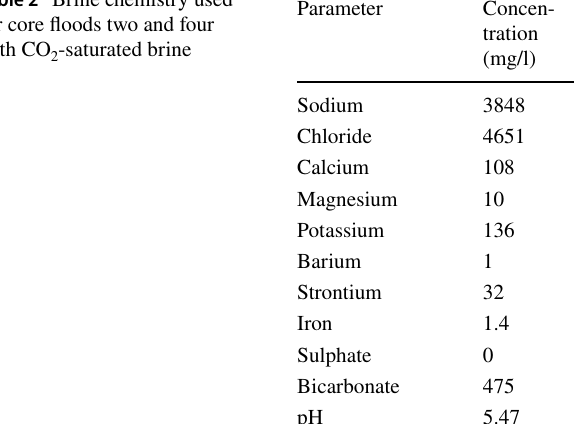
Table 2 Brine chemistry used for core floods two and four with CO 2 -saturated brine